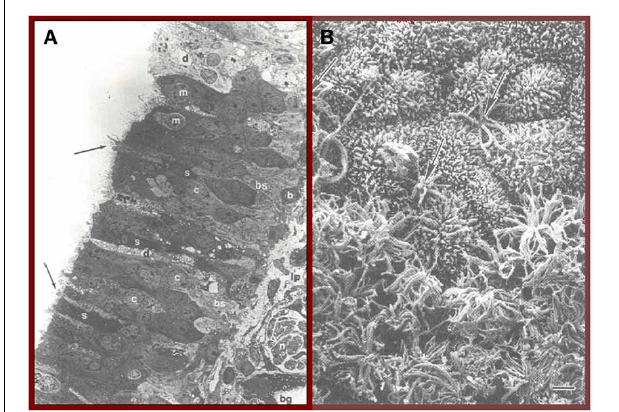
FIGURE 1 | (A) Cross-section of the human olfactory epithelium. Four main types of cells can be discerned: bipolar receptor cells (arrows point to largely denuded cilia at dendritic knobs); c, cell body, microvillar cells (m), sustentacular cells (s), and basal cells (b); bg, Bowman’s gland; lp, lamina propria; n, collection of axons within an ensheathing cell; d, degenerating cell; bs, basal cell undergoing mitosis. Photo courtesy of Dr. David Moran, Longmont, Colorado. (B) A transition zone between the human olfactory epithelium (bottom) and the respiratory epithelium (top). Arrows signify two examples of olfactory receptor cell dendrites with cilia that have been cut off. Bar = 5 μ m. From Menco and Morrison (2003), with permission. Copyright©2003, Marcel Dekker,